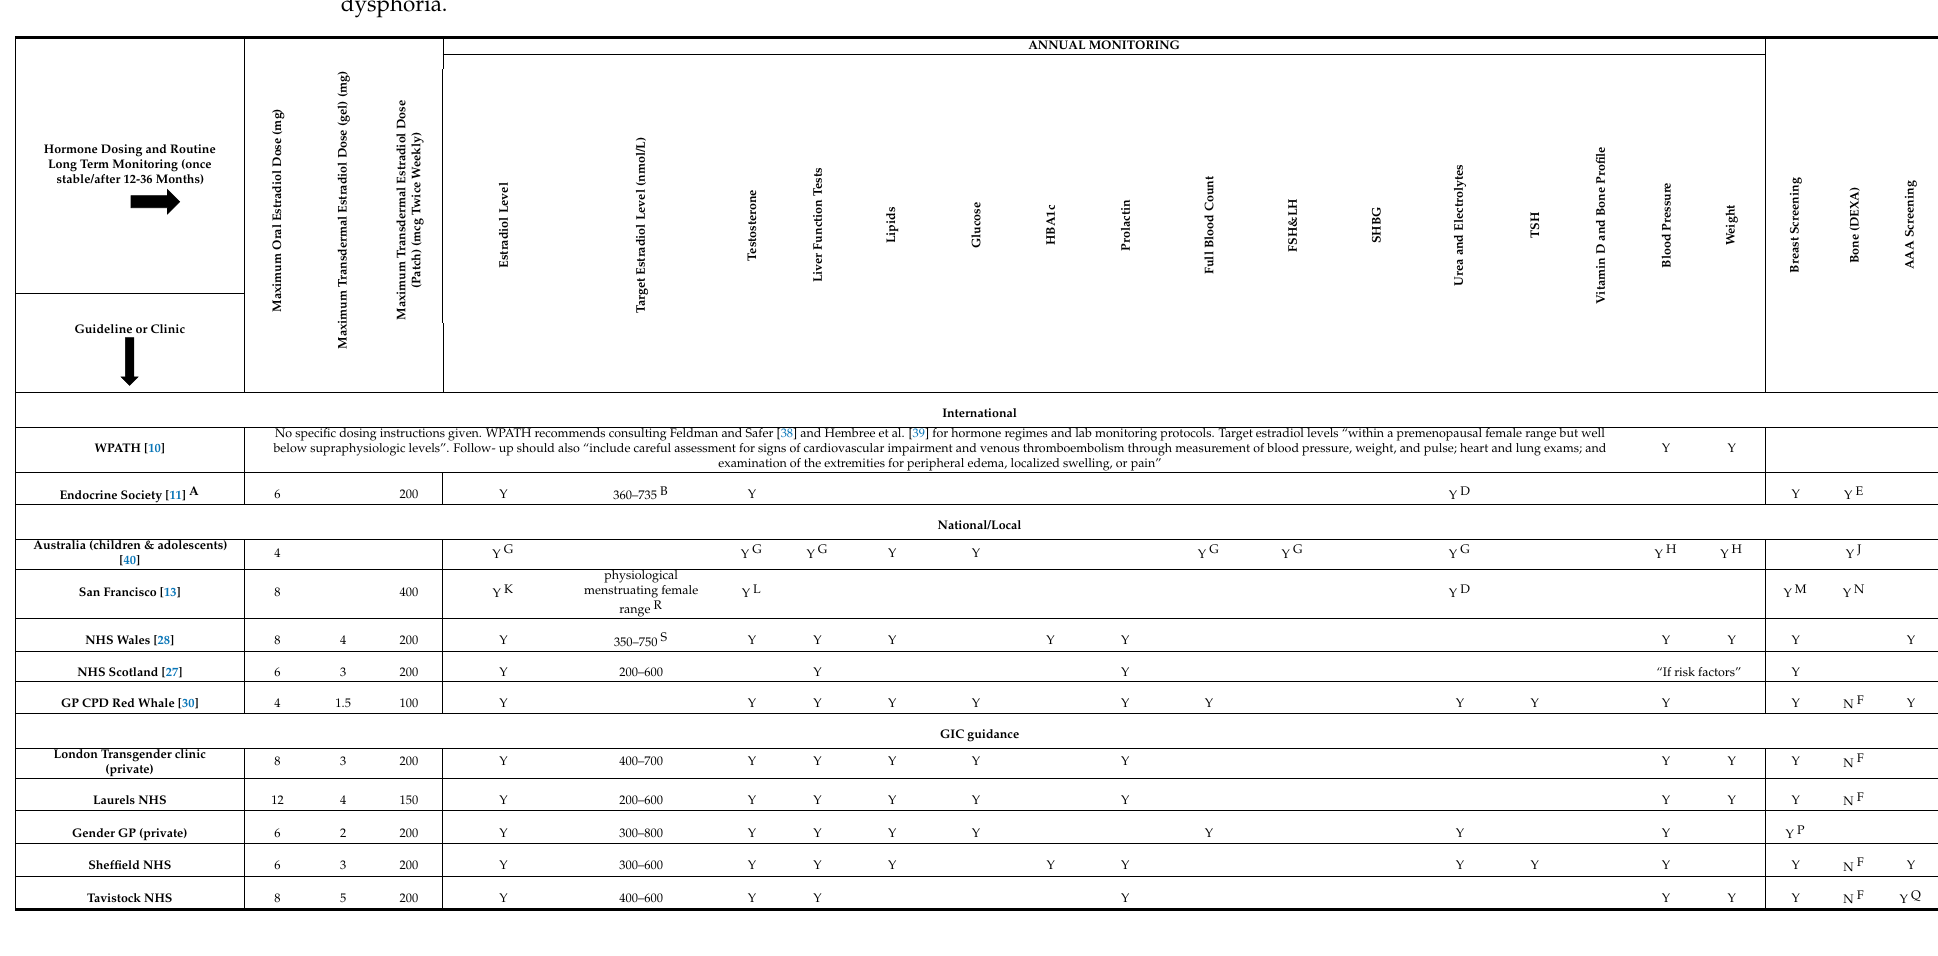
Table 2. Comparison of national, international, and patient specific prescribing and monitoring guidelines for trans women (observed males at birth) with gender dysphoria.